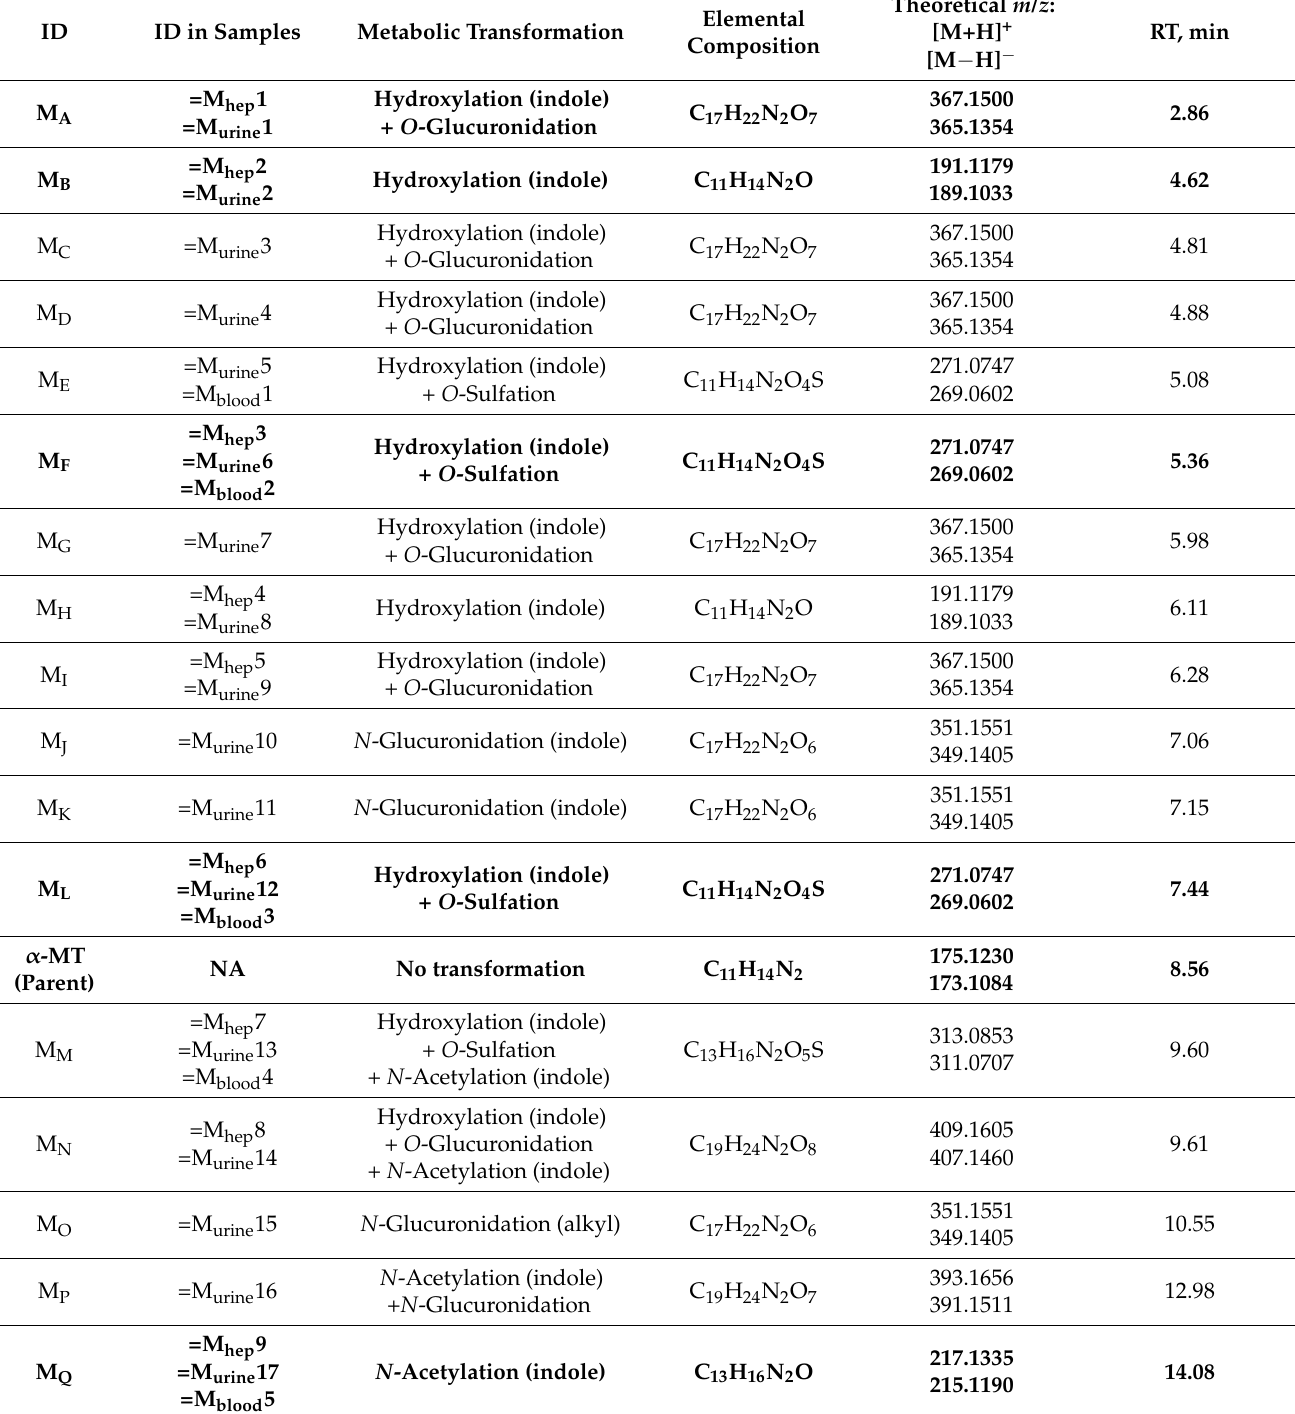
Table 4. Metabolic transformation, elemental composition, retention time (RT) in urine, and the- oretical accurate mass of molecular ion in positive- and negative-ionization modes ([M+H] + and [M-H] − , respectively) of α -MT and metabolites in hepatocyte incubations and postmortem samples. We suggest M A , M F , and M L as biomarkers of α -MT use in non-hydrolyzed urine, α -MT and M B in hydrolyzed urine, and α -MT, M F , M L , and M Q in